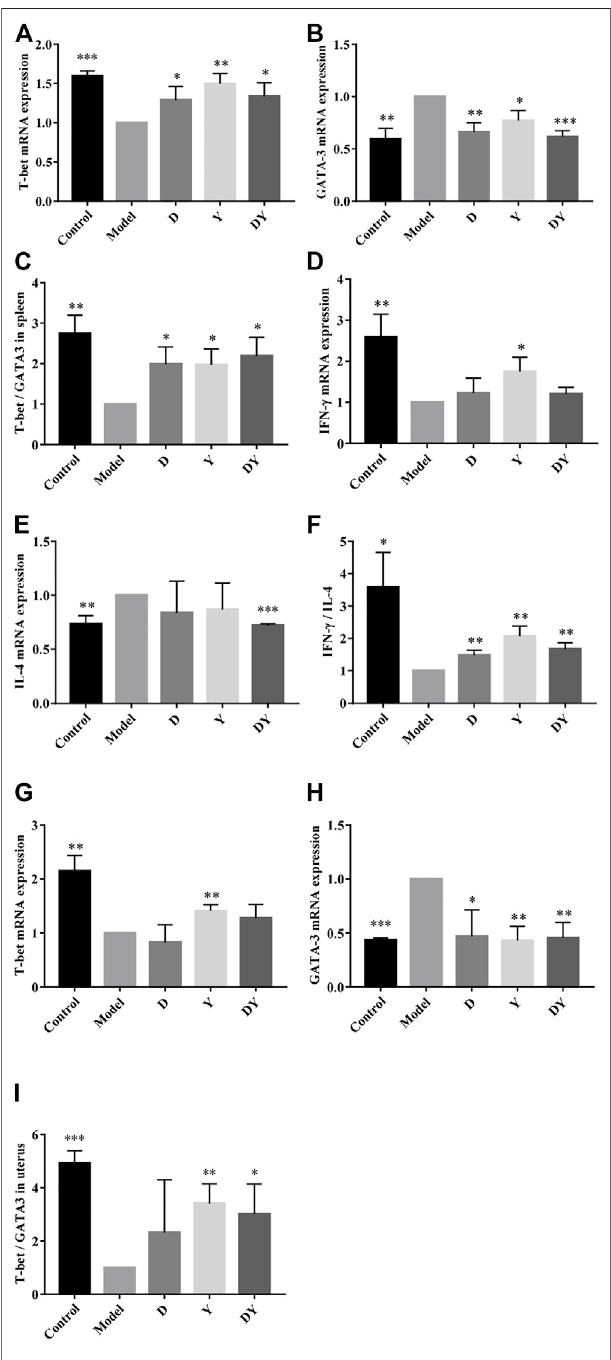
FIGURE3| DetectionofT-betandGATA-3mRNAexpressioninspleenand uterusbyRT-qPCR.ThemRNAexpressionofT-bet (A) andGATA-3 (B) inspleen. Evaluation of T-bet/GATA-3 in the spleen (C) . The mRNA expression of IFN- γ (D) and IL-4 (E) in spleen. Evaluation of IFN- γ /IL-4 in the spleen (F) . The mRNA expression of T-bet (G) and GATA-3 (H) in uterus. Evaluation of T-bet/GATA-3 in the uterus (I) . (*** p < 0.001, ** p < 0.01, and * p < 0.05, vs. Model group).